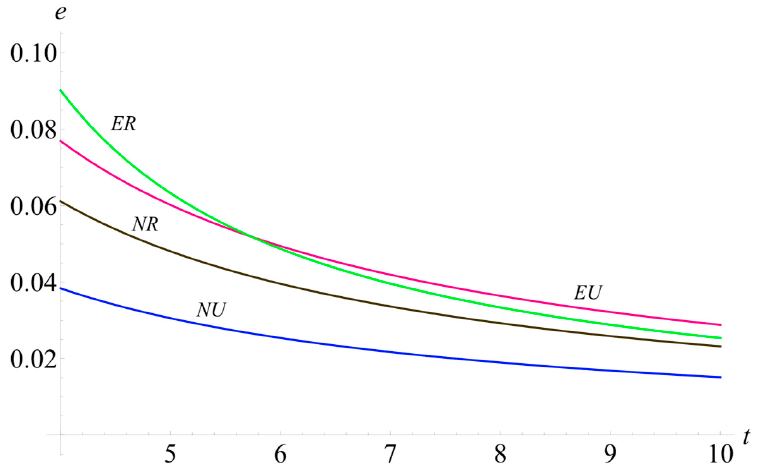
Figure 8. The impact of the cost coefficient of emission reduction on the carbon emission reduction levels.